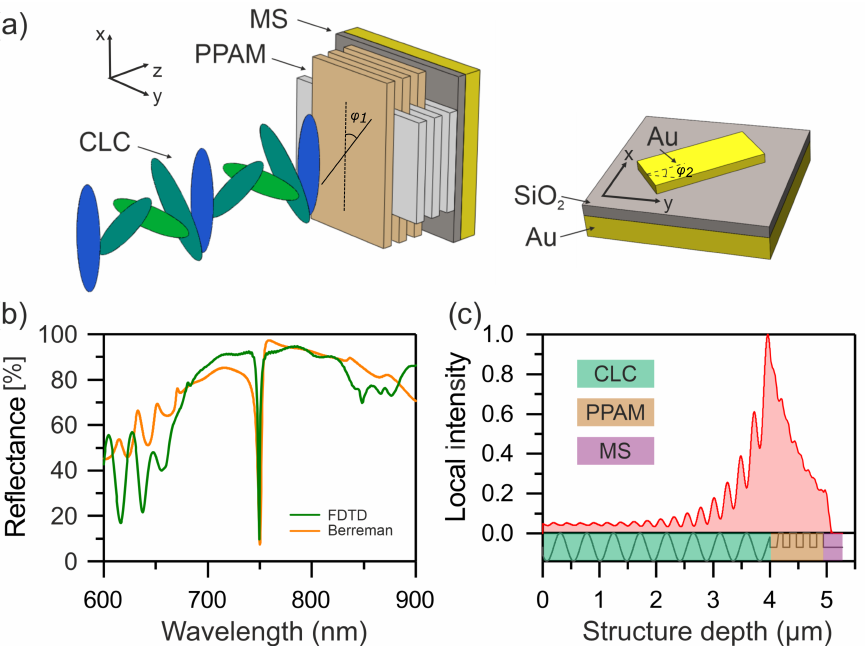
Figure 2. ( a ) Model of a hybrid structure for obtaining a high- Q COTS consisting of a CLC, PPAM, and MS (left). Schematic of the MS (right). ϕ 1 and ϕ 2 are the angles between the optical axes at the CLC-PPAM and PPAM-MS interfaces, respectively. ( b ) Reflectance spectra of the CLC–PPAM–MS structure calculated by the Berreman (orange line) and FDTD (green line) methods. ( c ) Local field intensity distribution at the COTS